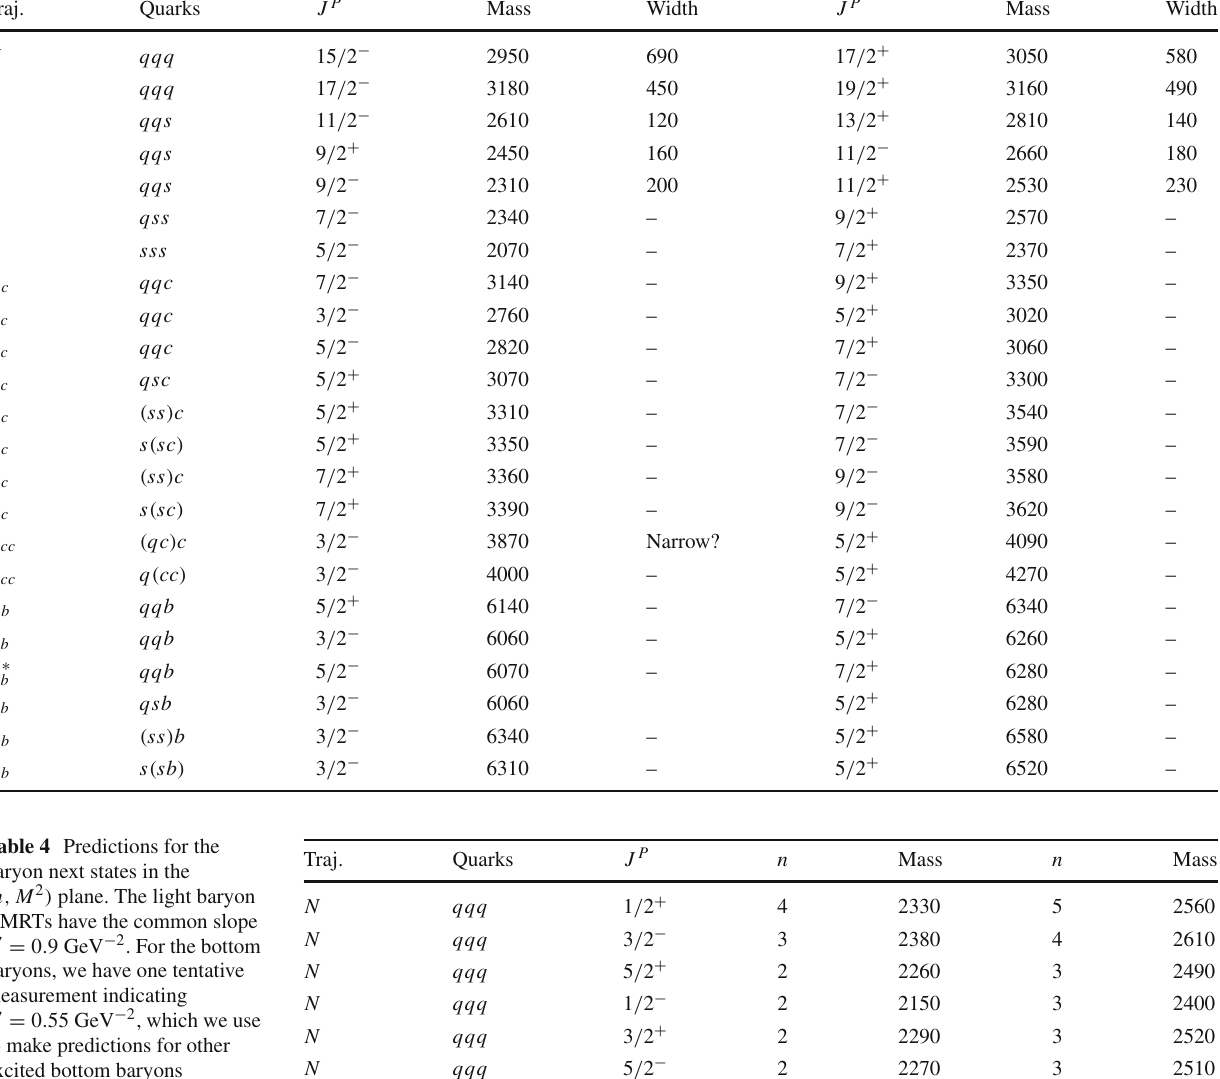
Table 3 Predictions for the baryon next states in the ( J , M 2 ) plane. In some cases, such as the (cid:11) cc , we list the two different predictions one gets when assuming different configurations of the diquark. q signifies